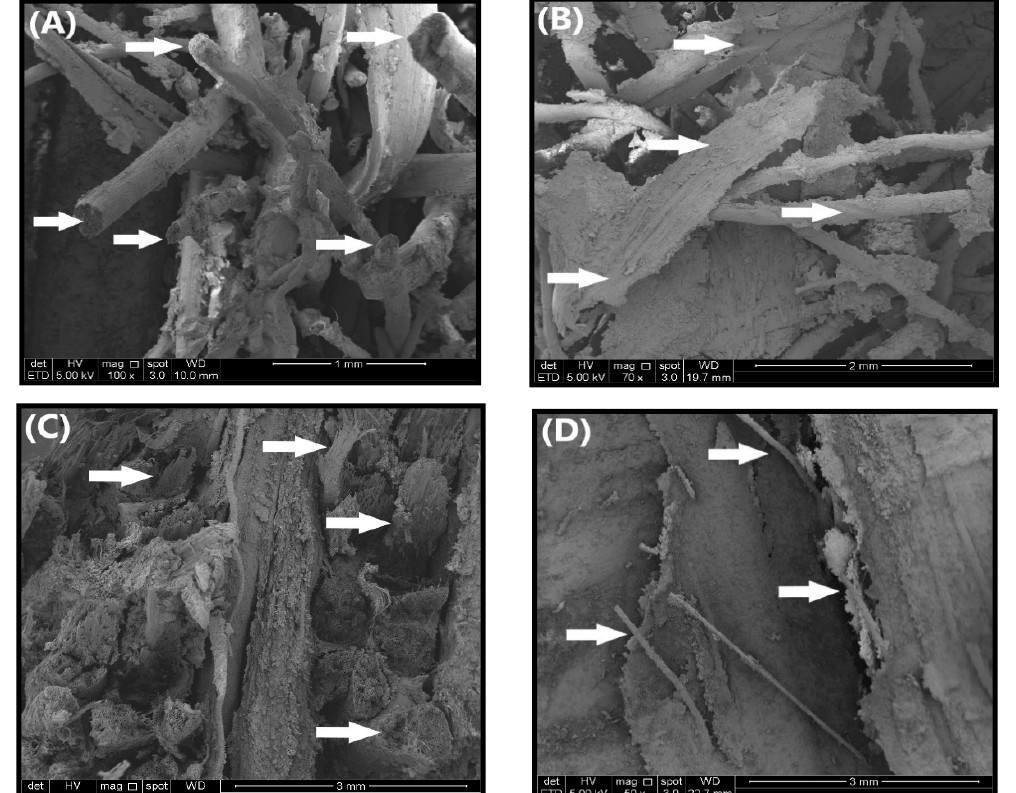
Figure 11. SEM micrograph of impact fracture morphology ( A ) PWH with neat PF resin; ( B ) PWH with PF resin-filled 4% OPA nanoparticles loading; ( C ) PWV with neat resin and ( D ) PWV with PF resin-filled 4% OPA nanoparticles loading.